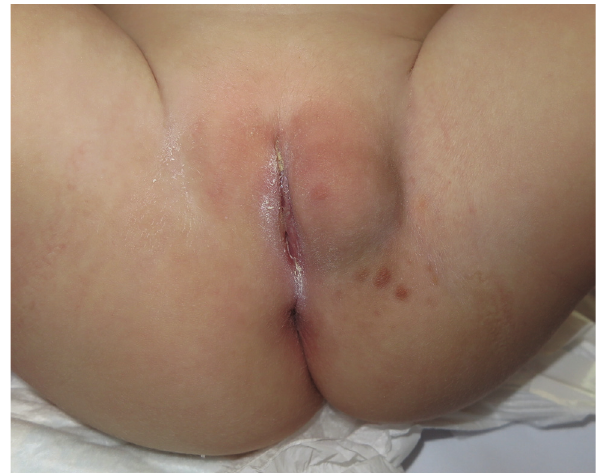
Fig. 1 Vulvar mass on the left labium majus surrounded by four cutaneous papules.